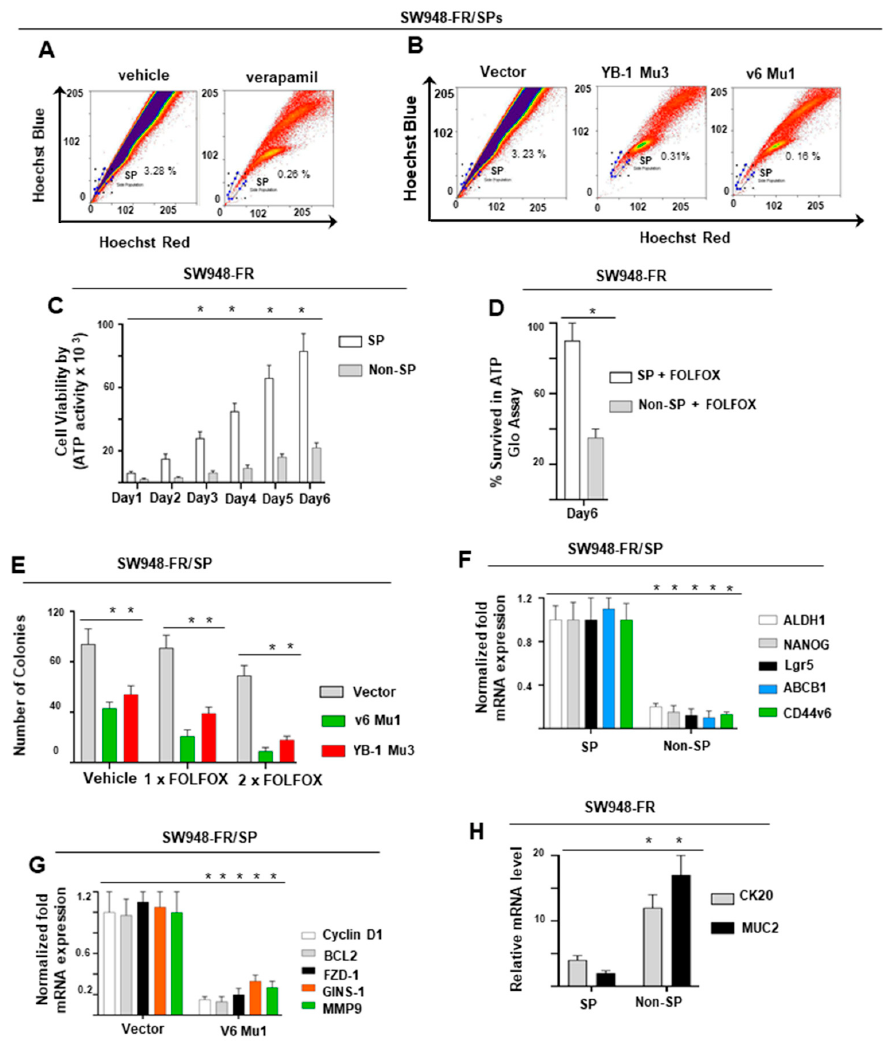
Figure 5. CD44v6-YB-1 defines CIC-like SP cells. ( A ) SW948-FR cells labeled with Hoechst 33342 showed 3.3% of SP cells in the SP gated region. Following treatment with verapamil, the SP cells were reduced to 0.26%. ( B ) v6 Mu1 and YB-1 Mu3 regulate the side population. The SP cells were <10% of vector cells in the v6 Mu1 cells, and the YB-1-Mu3 SW948-FR cells. ( C ) Cell proliferation rates were measured by ATP GLO assay for SP and non-SP cells. SP cells underwent rapid proliferation compared with non-SP cells. ( D ) SP cells exhibited high resistance to 1 × FOLFOX whereas the non-SP cells were sensitive to 1 × FOLFOX. ( E ) CD44v6 and YB-1 knockdown in SW948-FR cells decreased the drug resistance. Control, v6 Mu1, and YB-1 Mu3 SW948-FR cells were treated with various doses of FOLFOX for 10 days in 3% FBS DMEM. Cell viability was assessed using the clonogenic assay. The clonogenicity of CD44v6-Mu1 cells was significantly decreased compared with YB-1-Mu3 cells. ( F ) Expressions of core stemness genes in SW948-FR/SP and non-SP cells by QPCR are shown. ( G ) Expressions of anti-apoptosis/stemness-related genes in vector and v6 Mu1 transfected SW948-FR/SP cells are shown. ( H ) Expressions of CRC differentiation genes in SW948-FR/SP and non-SP cells are shown. Each bar represents the means of three determinations ± SD. * p < 0.05 among the indicated groups compared to respective control group. FACs data are representative of three